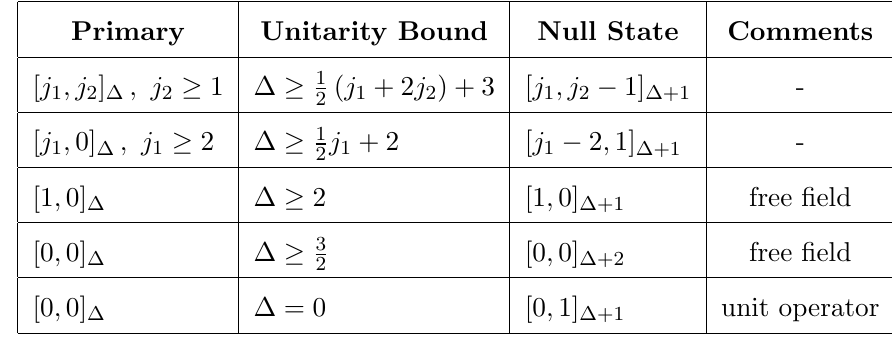
Table 27 . Unitary representations of the conformal algebra in d = 5.